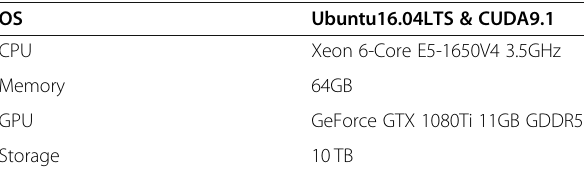
Table 1 The specifications for implementation of the experimental system